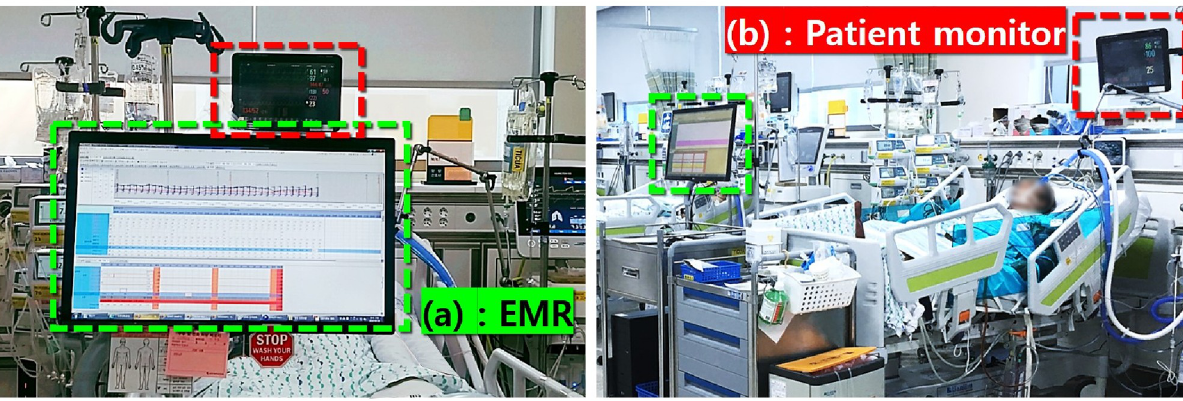
Fig 3. A patient bed at the target university hospital’s TICU. The computer displaying the EMR information (green box) for each patient is located in front of each TICU bed (a). The patient monitoring device (red box), collecting physiological signals (e.g., ECG, SpO2), is positioned near the head of the patient with its sensors attached to the patient on the bed